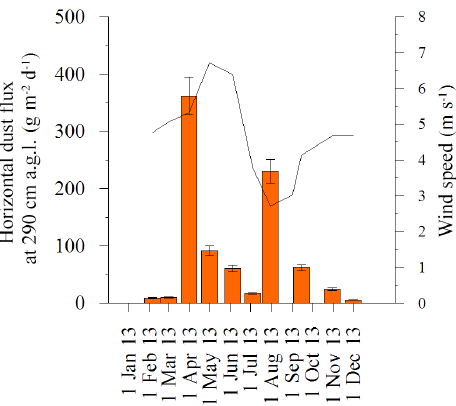
Figure 2. Horizontal transport fluxes of Saharan dust from the land- based MWAC sampler in Iouîk, Mauritania (19 ◦ N, 16 ◦ W) between January and December 2013 in orange bars. Error bars show the MWAC sampler efficiency of 75 to 90%. Monthly-averaged wind speed at 10m above displacement height (MERRA model) around the Iouîk location is indicated as a black line (data obtained from the Giovanni online data system, NASA GES DISC); a.g.l. = above ground level.